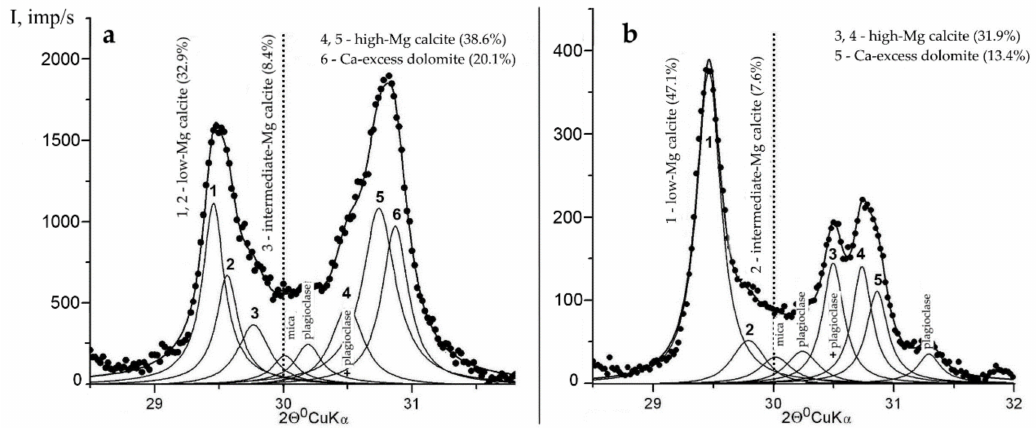
Figure 2. Practical application of the modeling complex XRD-profiles’ method of low-temperature carbonates in lacustrine sediments. Experimental profiles—dotted line, model profiles (individual and total)—solid line. The total content of carbonates in the sample was assumed to be